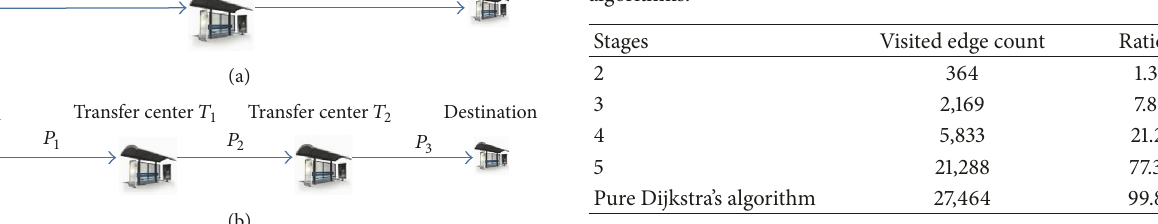
Table 1: Visited edge counts for modified and pure Dijkstra’s